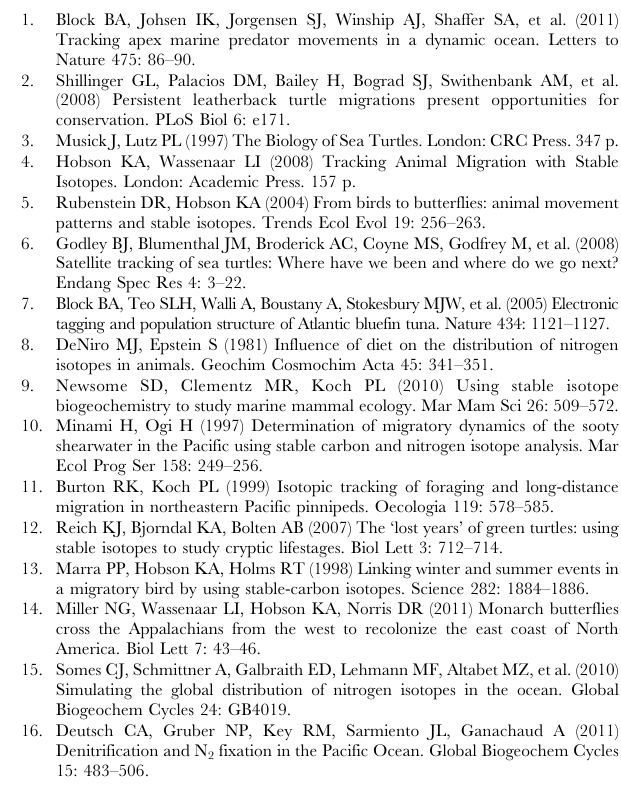
Table S2 Bulk d 15 N and d 13 C and compound specific d 15